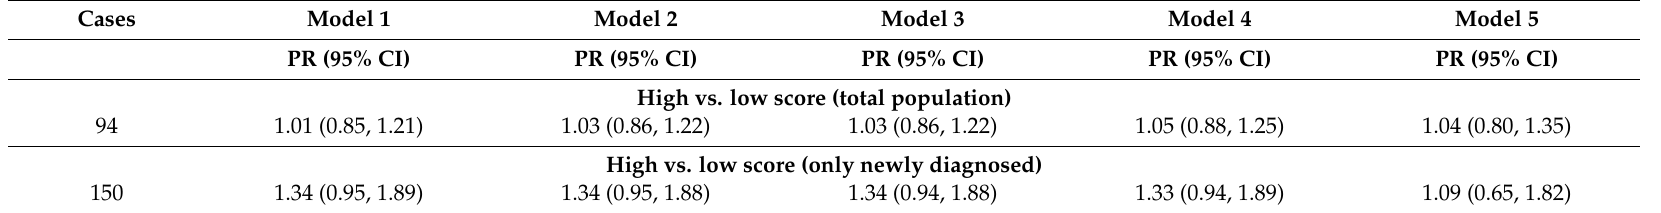
Table 3. Association of high adherence to the HSHF dietary pattern with T2D in the total study